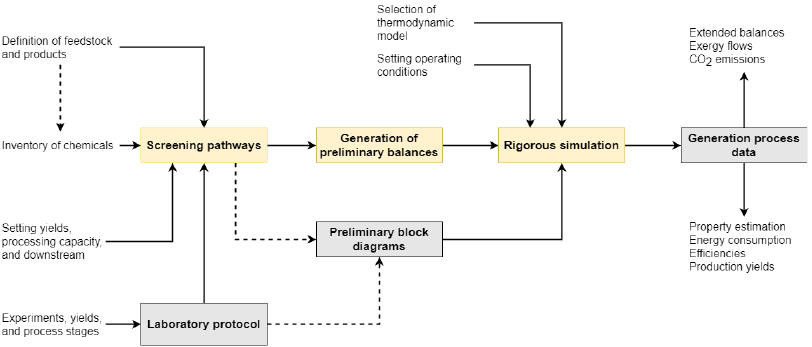
Figure 2. A generalized scheme to generate process data of bioprocesses and emerging technologies using process simulation.